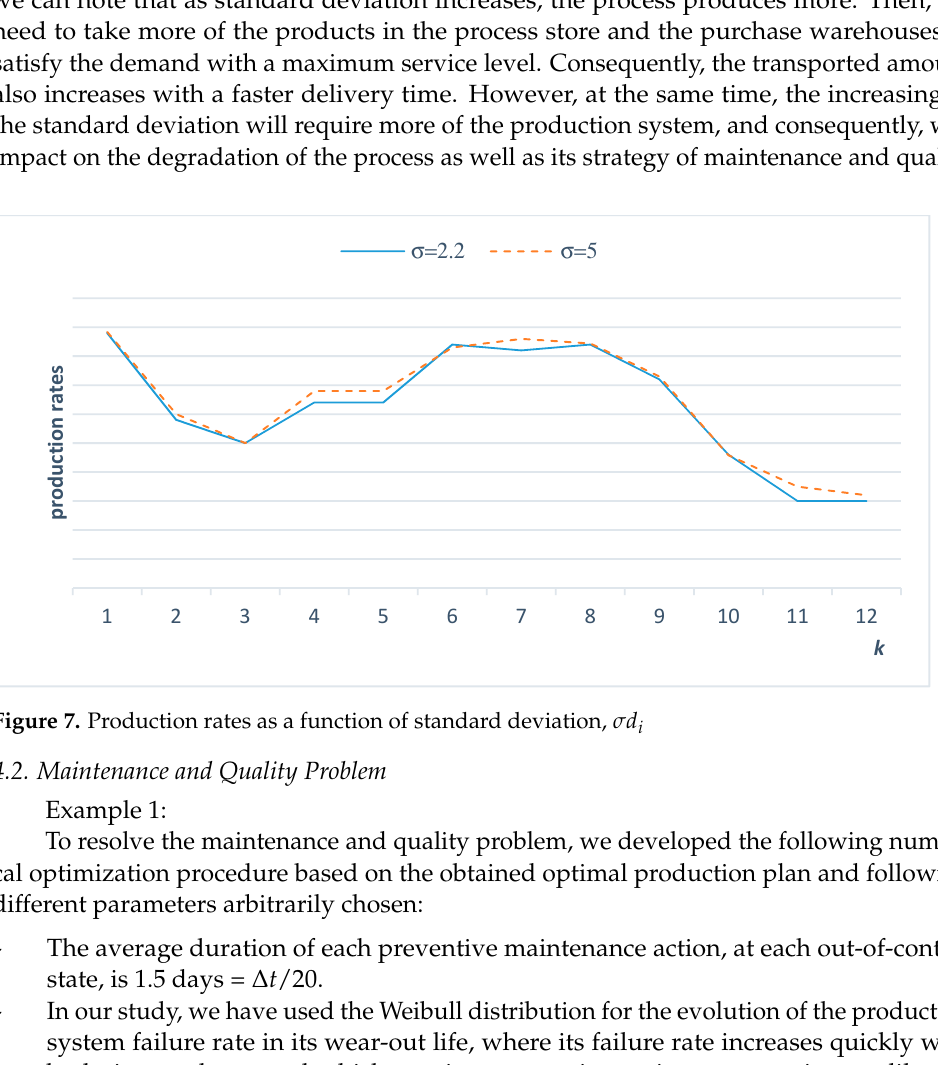
Table 14. Optimal control chart parameters. (cid:2196) *